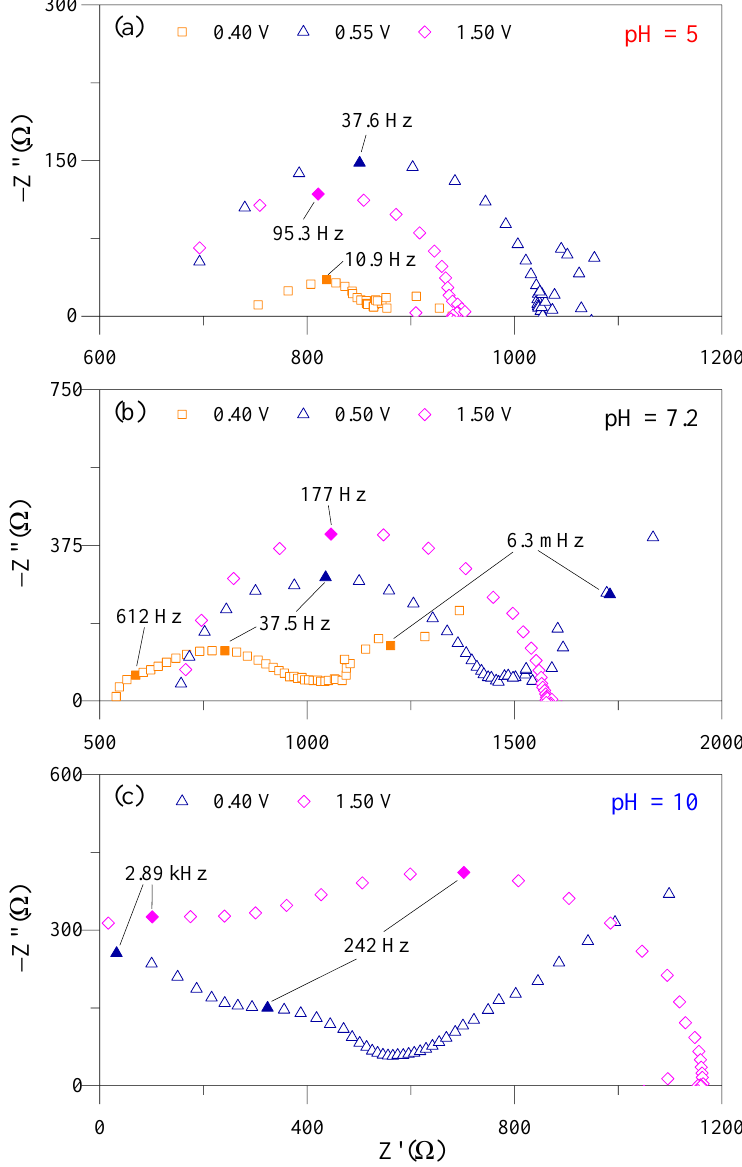
Figure 5. Electrochemical impedance spectroscopy spectra for the 0.001 M H x PO 4 3 − x solution at ( a ) pH 5, ( b ) pH 7 and ( c ) pH 10. The impedances were obtained at bias potentials corresponding to the i lim,1 < i < i lim,2 (orange, when applicable), i = i lim,2 (blue) and i > i lim,2 (pink) region of the polarization curve. Solid points refer to characteristic frequencies.